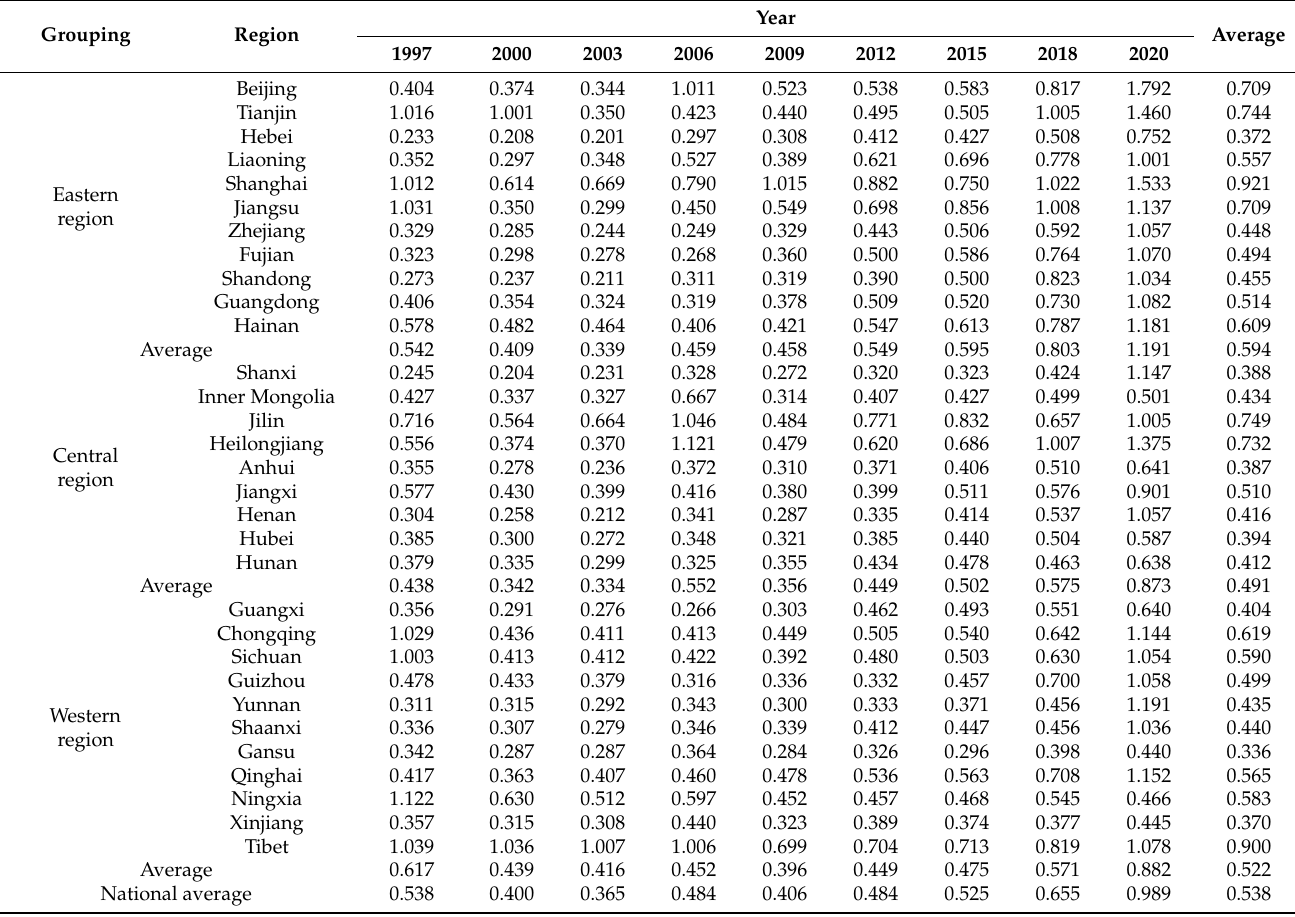
Table 5. Results of green efficiency of agricultural water use in China from 1997 to 2020.